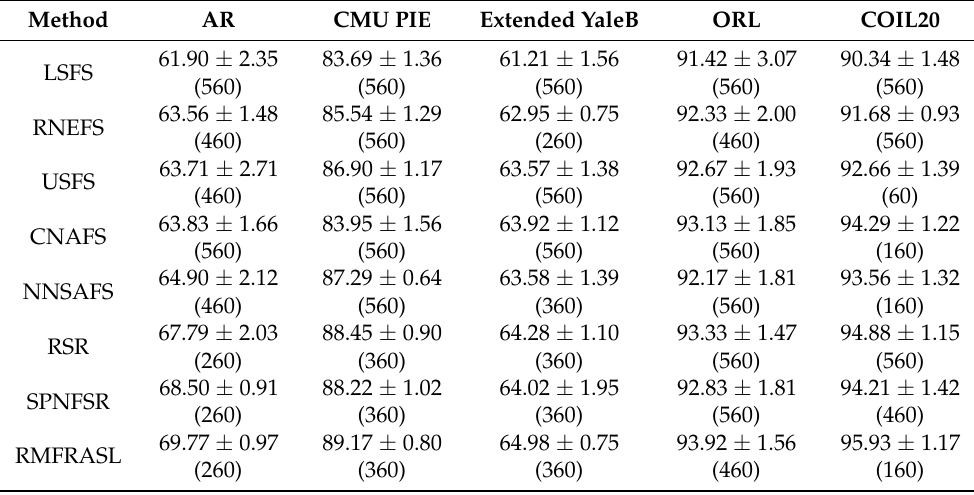
Table 7. The best accuracy rate and STD of different algorithms on the five